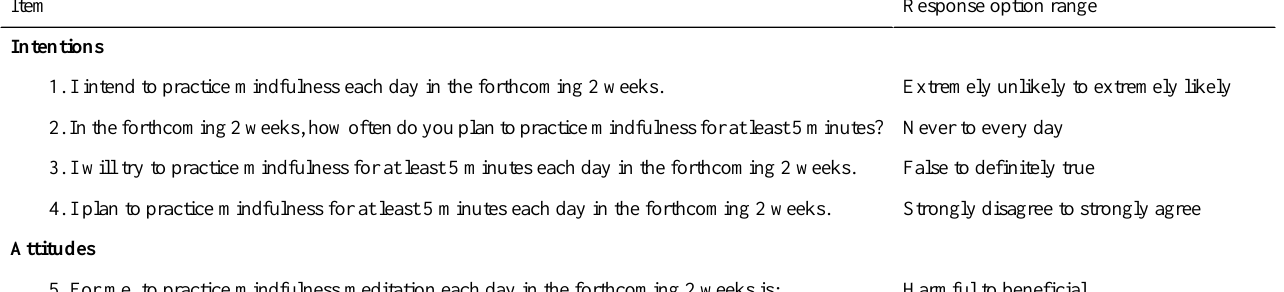
Table 1. Theory of Planned Behavior items